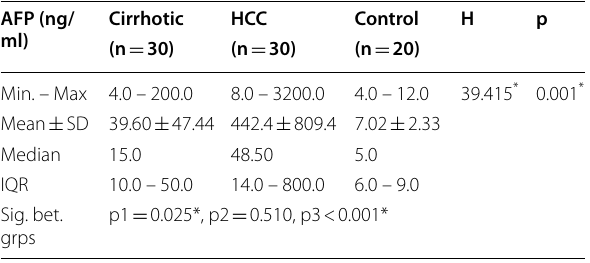
Table 4 Comparison between the three studied groups according to AFP